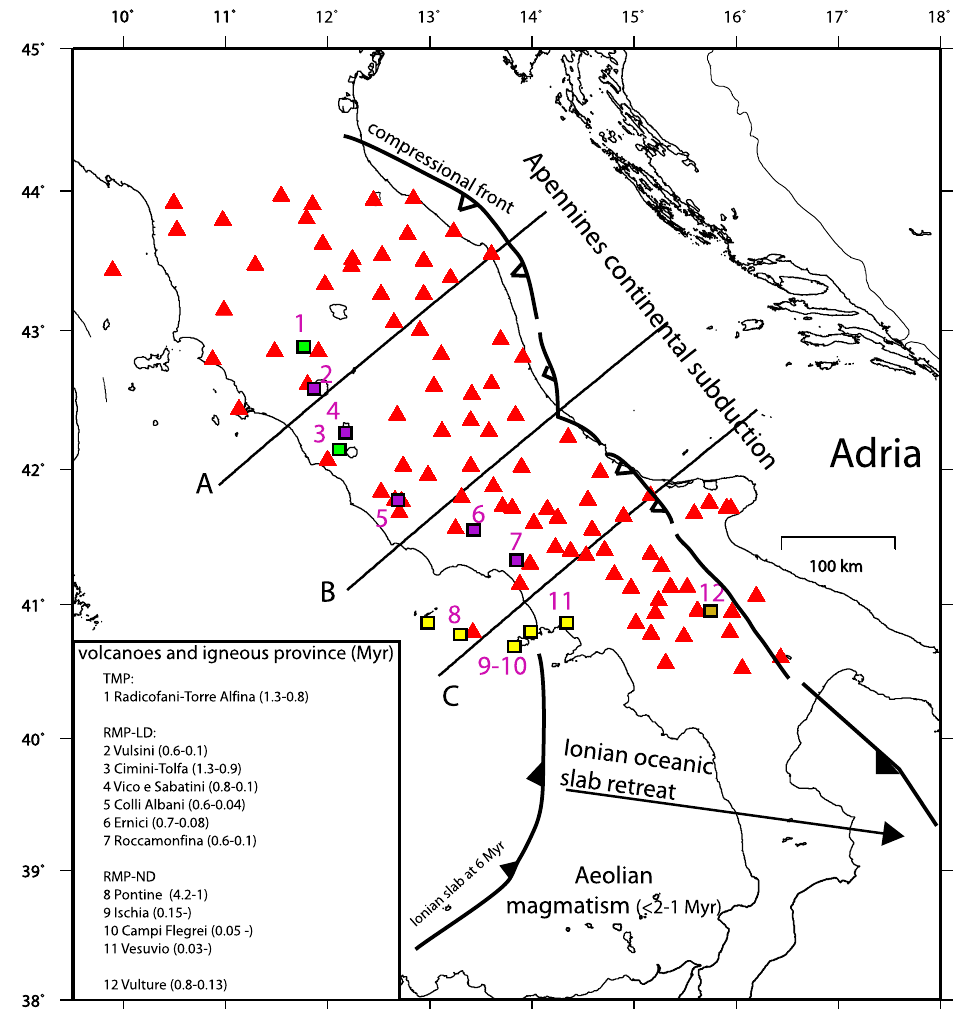
Figure 1. Sketch of the study area showing the seismic stations (red triangles) used in the tomography, main magmatic centers with date or activity, and tectonic lineaments. Classification from 20 green = Tuscan Magmatic Province (TMP), purple = Roman Magmatic Province Latium district (RMP-LD), yellow = Roman Magmatic Province Neapolitan district (RMP-ND). Traces of vertical sections in Fig. 3 are